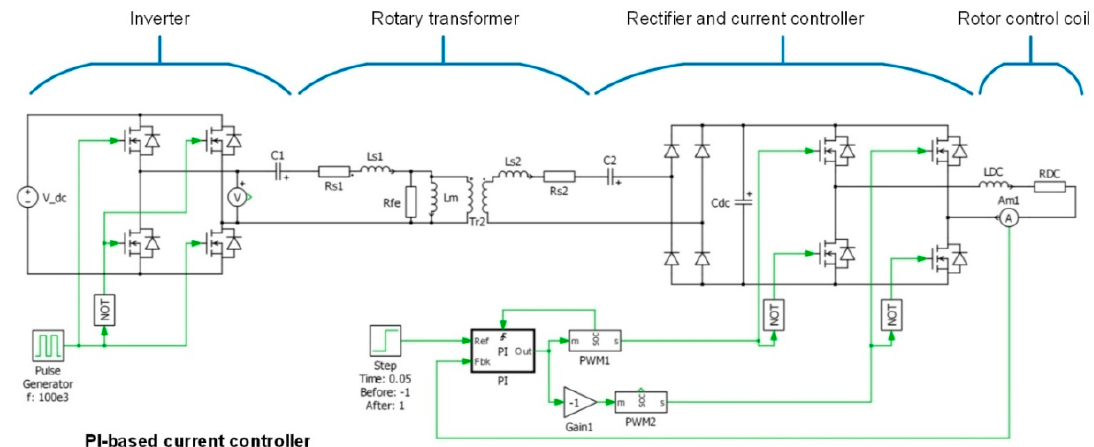
Figure 10. Time domain simulation model of the contactless energy transfer system.